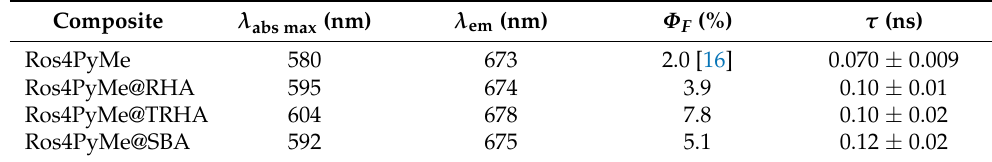
Table 2. Spectroscopic properties of Ros4PyMe and Ros4PyMe@adsorbent composites in water and 25 ◦